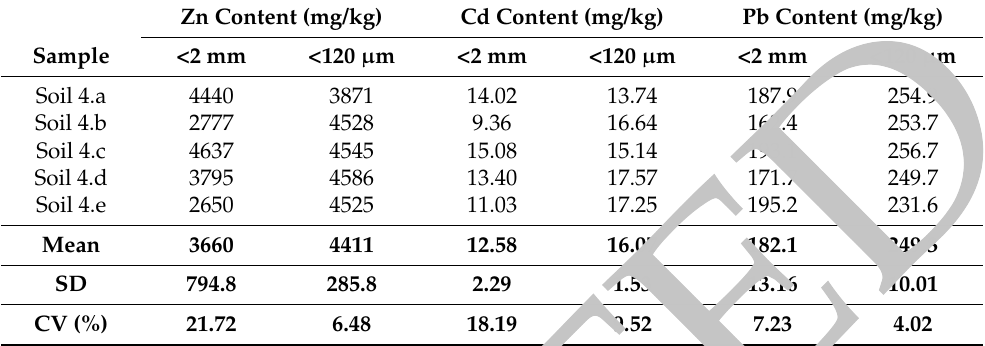
Table 2. Results from duplicate analyses for determining precision levels. Standard deviation (sd) is calculated using the range of values multiplied by 0.4. Precision within this study is expressed as ± two coefficients of variance (cv), i.e., at a confidence level of 95%. Zn Content (mg/kg) Cd Content (mg/kg) Pb Content